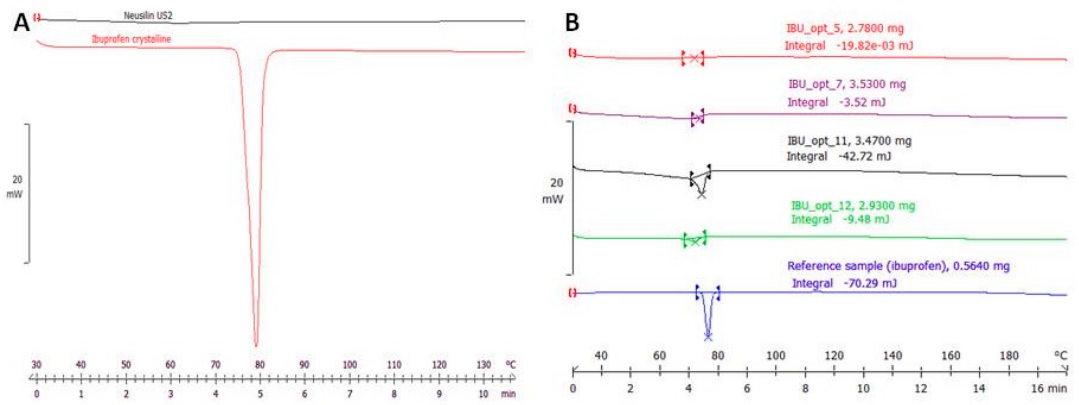
Figure 1. ( A ) Thermal analysis of crystalline ibuprofen (IBU) and amorphous Neusilin US2. ( B ) Differential scanning calorimetry (DSC) thermograms of samples obtained from the hot melt impregnation (HMI) process as examples.